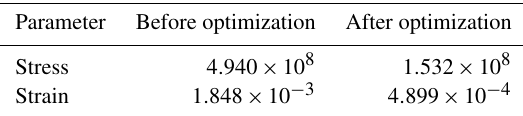
Table 5. Data comparison before and after